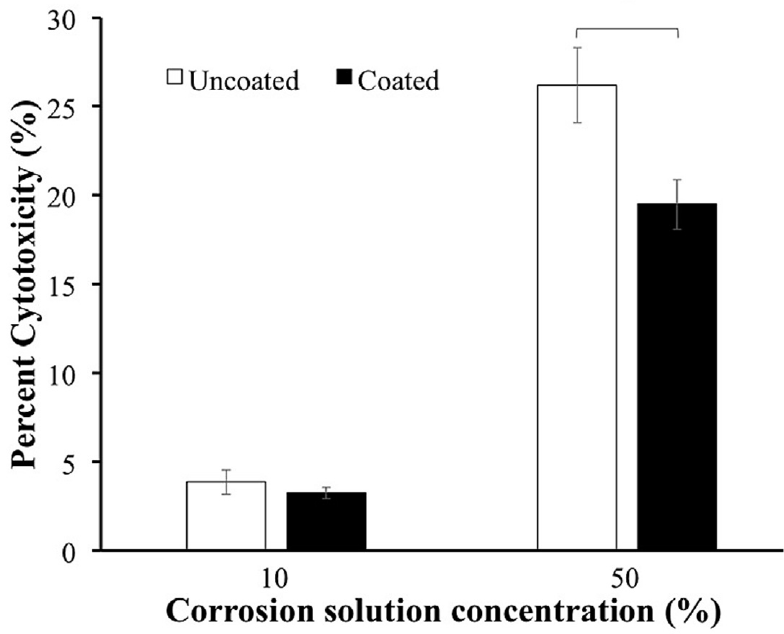
Figure 7. Percentage cytotoxicity of neurons after 24 h exposure to medium (for coated/uncoated sample) corroded over 3 days, analyzed using live/dead staining [100]. Reproduced with permission from Elsevier.